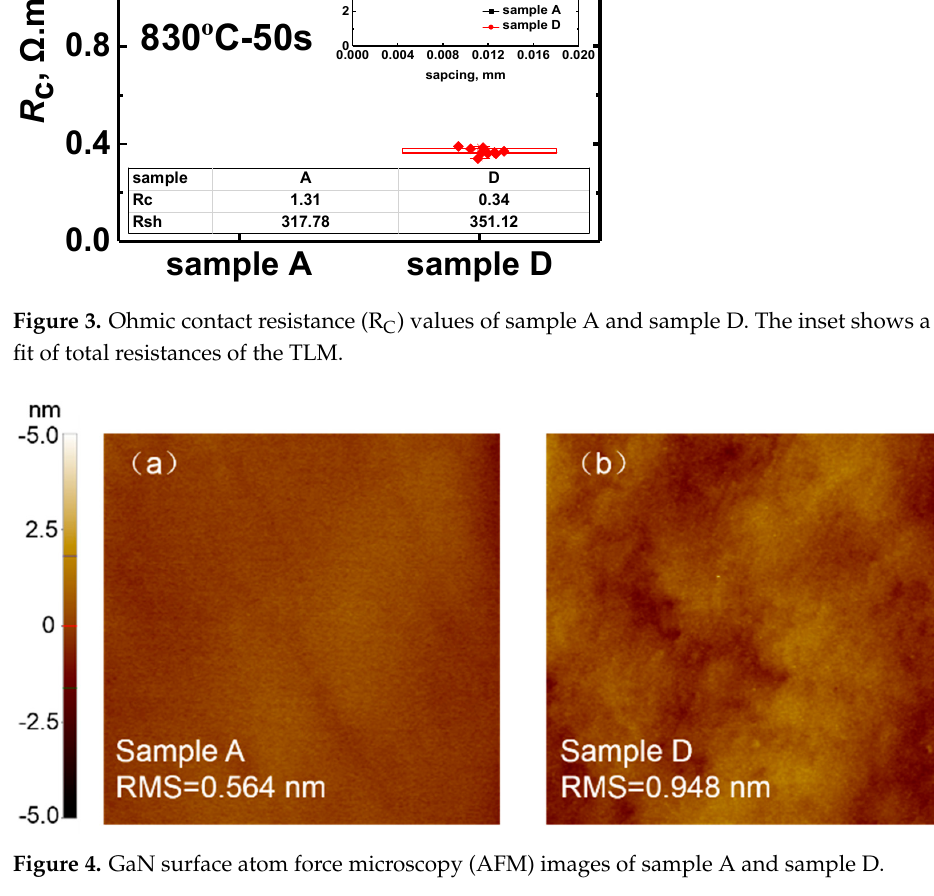
Figure 4. GaN surface atom force microscopy (AFM) images of sample A and sample D.